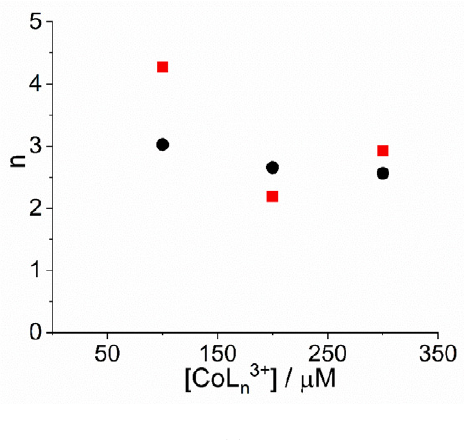
Figure 3. Plot of ( a ) the rate constants k c (s − 1 ) and ( b ) the size of the critical nucleus, m , and ( c ) the time exponent n for the catalyzed growth of J-aggregates of H 2 TPPS 4 at pH = 2 upon addition of [Co(phen) 3 ] 3+ (circles) and [Co(NH 3 ) 6 ] 3+ (solid squares). (Experimental conditions: [H 2 TPPS 4 ] = 3 µM; [HCl] = 0.01 M, T = 298 K). The solid lines in panel a represent the linear best-fits to the law kc = kc’ × [CoL n3+ ].